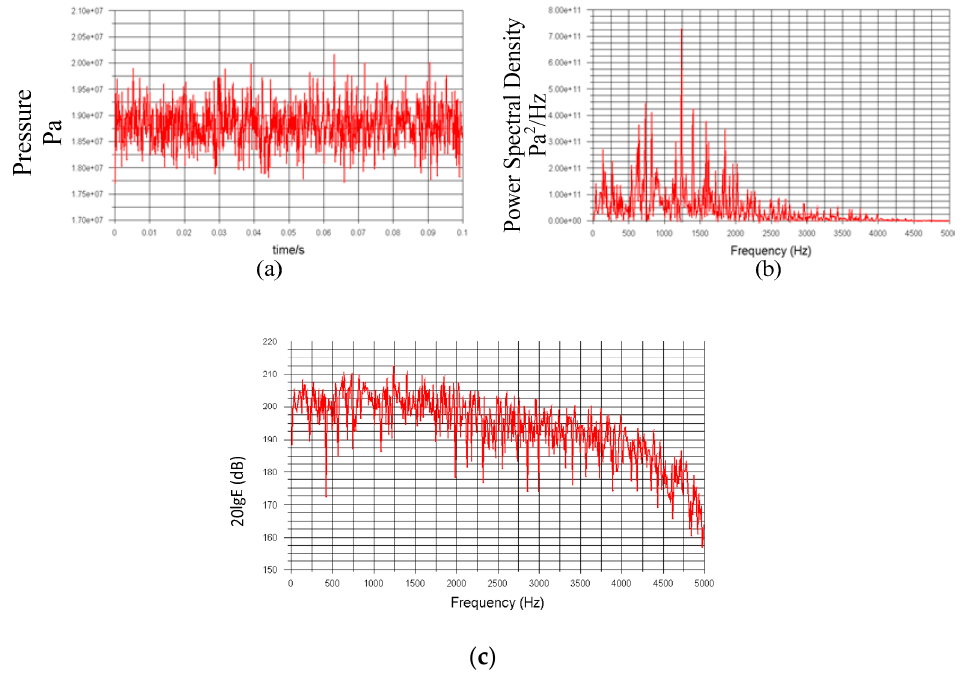
Figure 10. Pressure curves in time and frequency domains when the inlet velocity is 50 m/s. ( a ) Time domain. ( b ) Frequency domain. ( c ) 20logE frequency domain.